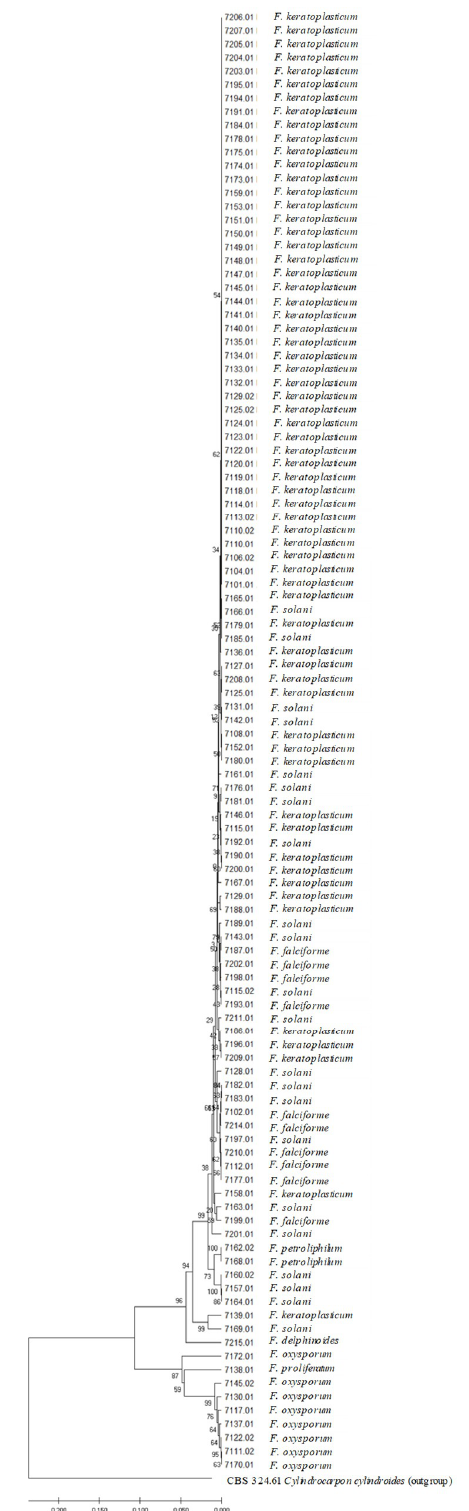
Figure 2. Dendrogram based on concatenated sequences of ITS and EF-1α from 108 Fusarium spp. clinical isolates. In the tree nodes are the percentage of the bootstrap. Scale bar indicates nucleotide substitutions per site. FSSC: Fusarium solani species complex; FOSC: F. oxysporum species complex; FFSC: F. fujikuroi species complex; FDSC: F. dimerum species complex. Outgroup: Cylindrocarpon cylindroides strain CBS 324.61.